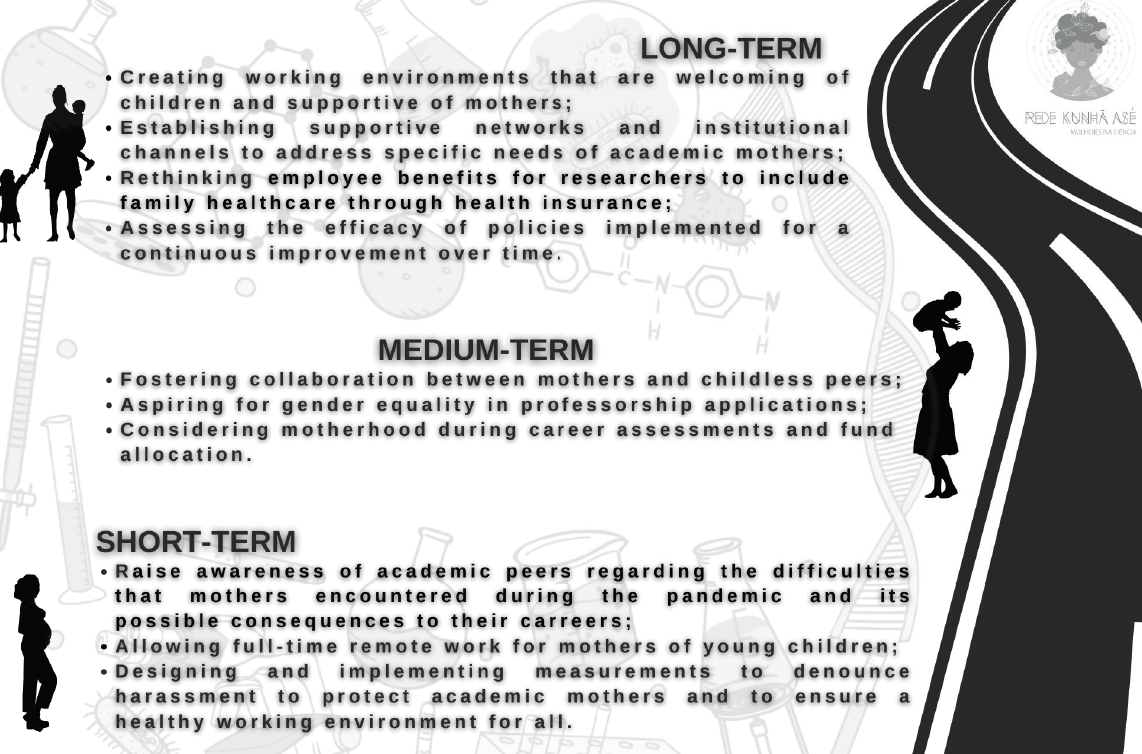
Figure 1. Strategies to lessen the impact of COVID-19 on academic mothers over